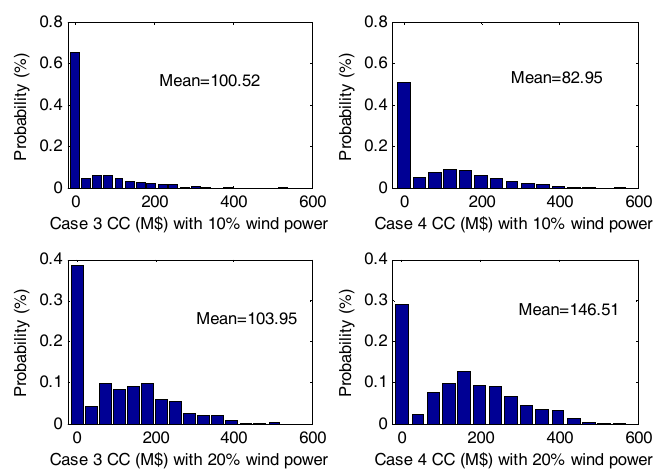
Figure 10. Tradeoffs between cost and risk for cases 3 and 4 for the Polish 2383-bus system.